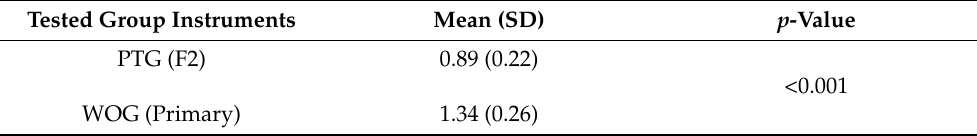
Table 1. Maximum force (N) per system excreted during radicular preparation. Tested Group Instruments Mean (SD) p -Value PTG (F2) 23.00 (4.43) WOG (Primary) 15.21 (3.46) PTG, ProTaper Gold; WOG, WaveOne Gold; SD, standard deviation. Table 2. Cutting efficiency (mm) by engine-driven endodontic instrumentation system. Tested Group Instruments Mean (SD) p -Value PTG (F2) 0.89 (0.22) WOG (Primary) 1.34 (0.26) PTG, ProTaper Gold; WOG, WaveOne Gold; SD, standard